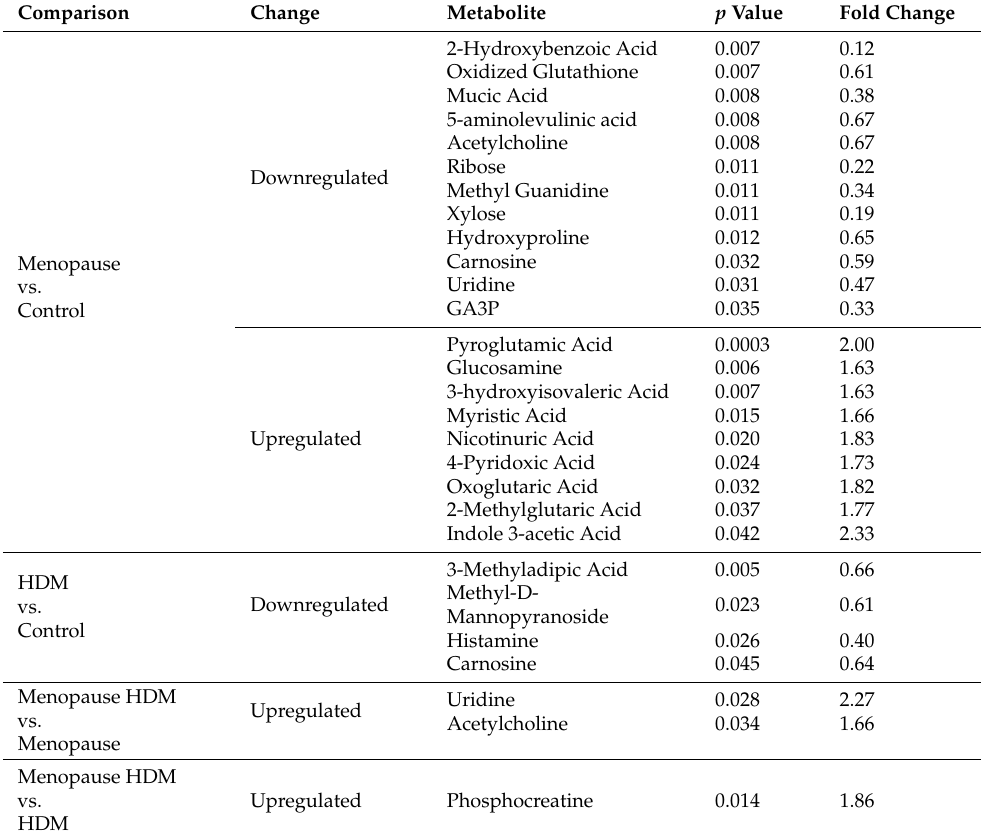
Figure 2. Significantly different metabolites across the four experimental groups by one-way ANOVA with multiple comparisons. ( A ) 9-Octadecynoic acid in BALF; ( B ) acetamide in BALF; ( C ) cytosine in BALF; ( D ) pyroglutamic acid in serum. * p ≤ 0.05, ** p ≤ 0.005, *** p ≤ 0.0005, **** p ≤ 0.00005. Table 2. Significantly different individual metabolites in the serum.